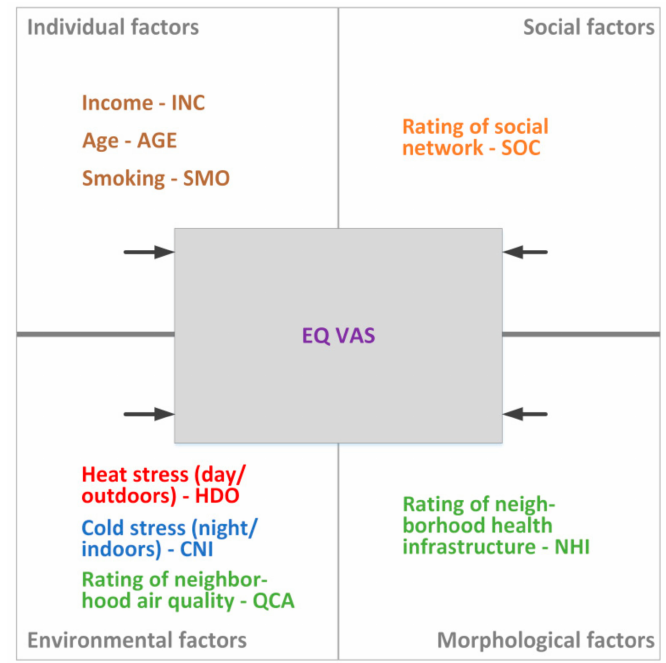
Figure 3. Urban variables identified with significant influence on